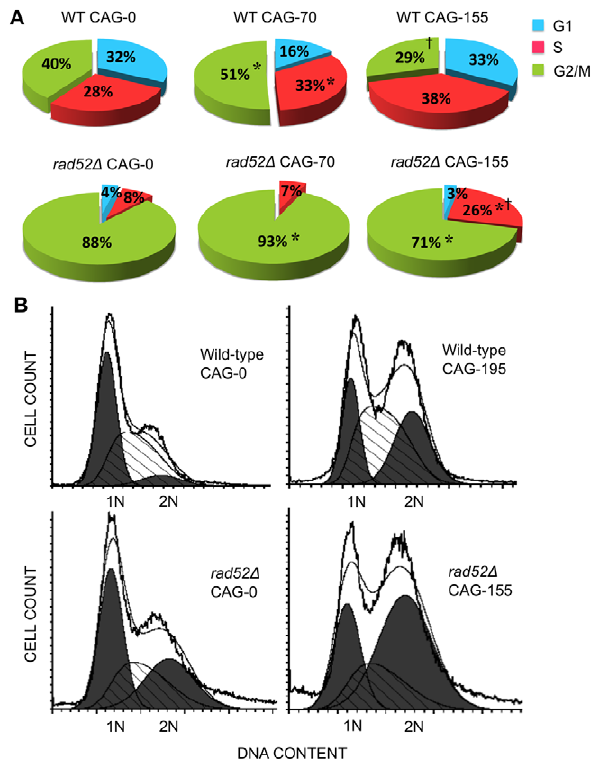
Figure 4. Cell cycle position of arrests. (A) Indicates cell cycle position of arrests ( . 3.0 hrs) observed for actively dividing cells on YC- Leu solid media in the single cell pedigree analysis. Arrests defined as . 60 9 for G1, . 45 9 for S, . 60 9 for G2/M. Not included are normal divisions , 3.0 hours that showed an S phase or G2/M delay. Statistically significant comparisons to CAG-0 (*) or between CAG-70 and CAG-155 strains ( { ) within genotype are indicated. Statistics performed by logistic regression analysis on raw data calculated out of total # of divisions (Table S1). (B) FACS analysis of DNA collected from wild-type or rad52 D cells in near-stationary phase liquid cultures, with 0, 195, or 155 repeats. Unfilled curves show DNA content, either raw data (jagged line), or smoothened data generated by ModFit software. Filled and hatched histograms denote putative G1 or G2 and S phases,